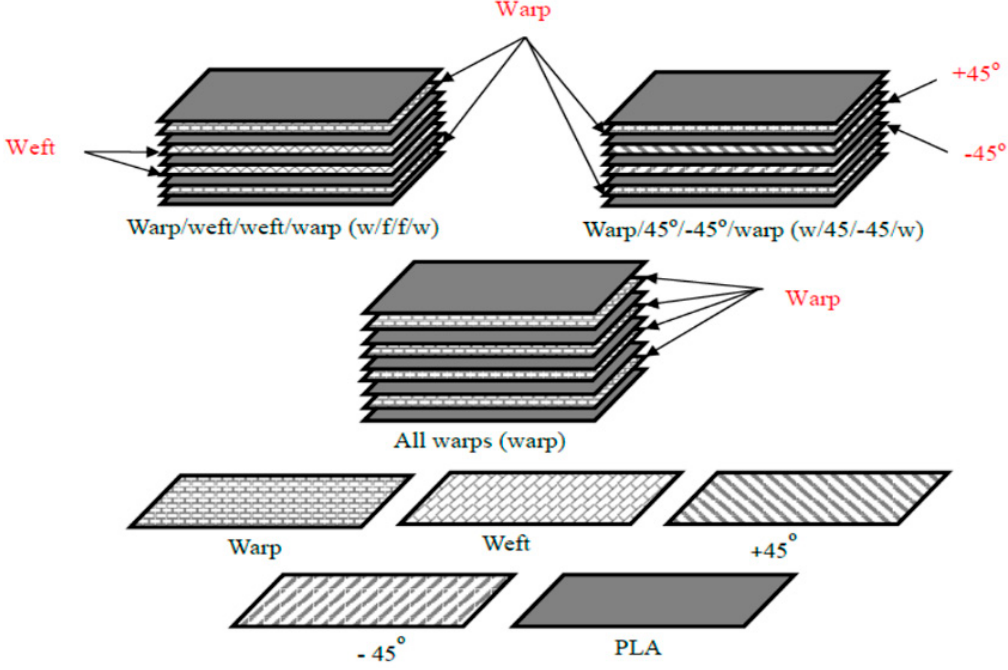
Figure 3. Schematic illustrations of laminates with various bamboo fabric stacking sequences.